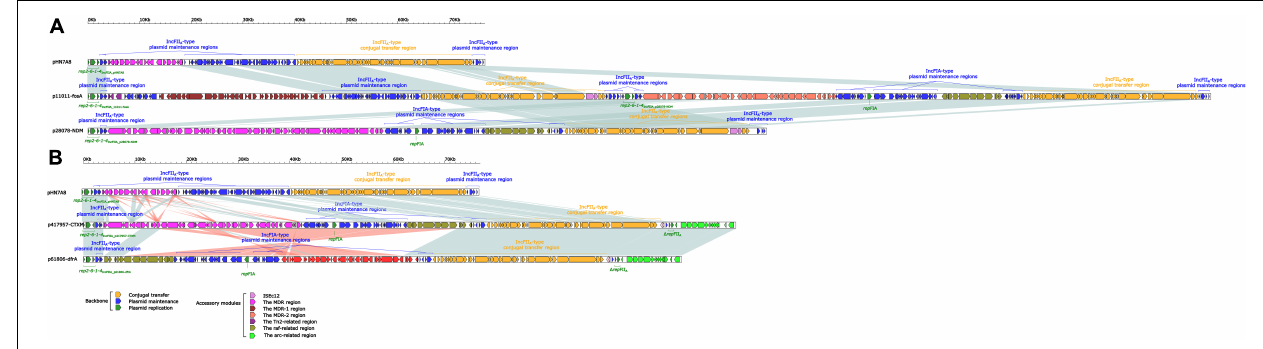
FIGURE 2 | (A) Linear comparison of p11011-fosA with related plasmids. (B) Linear comparison of p417957-CTXM with related plasmids. Genes are indicated by arrows. Genes, mobile elements and other features are colored based on functional classification. Shadows indicate nucleotide homology is greater than 95%. p11011-fosA and p417957-CTXM were sequenced in this study, while the sequence of pHN7A8, p28078-NDM, and p61806- dfrA was from GenBank as reference plasmids.